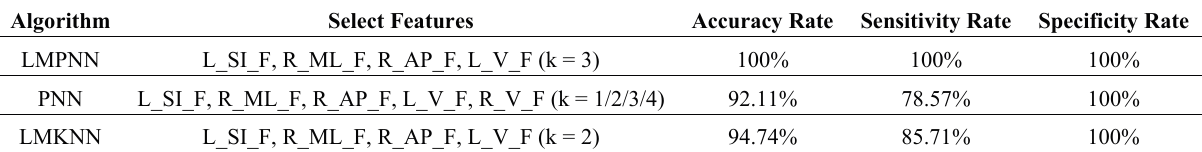
Table 3. The selected features and relevant classification performance for the three classification algorithms.